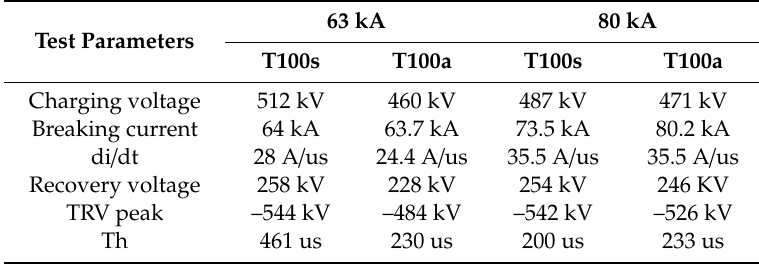
Figure 10. Test waveforms of the synthetic breaking test at 80 kA. Table 5. Results of the breaking test.